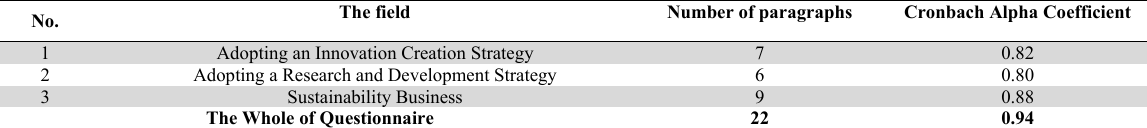
Cronbach's alpha coefficients for the fields of study